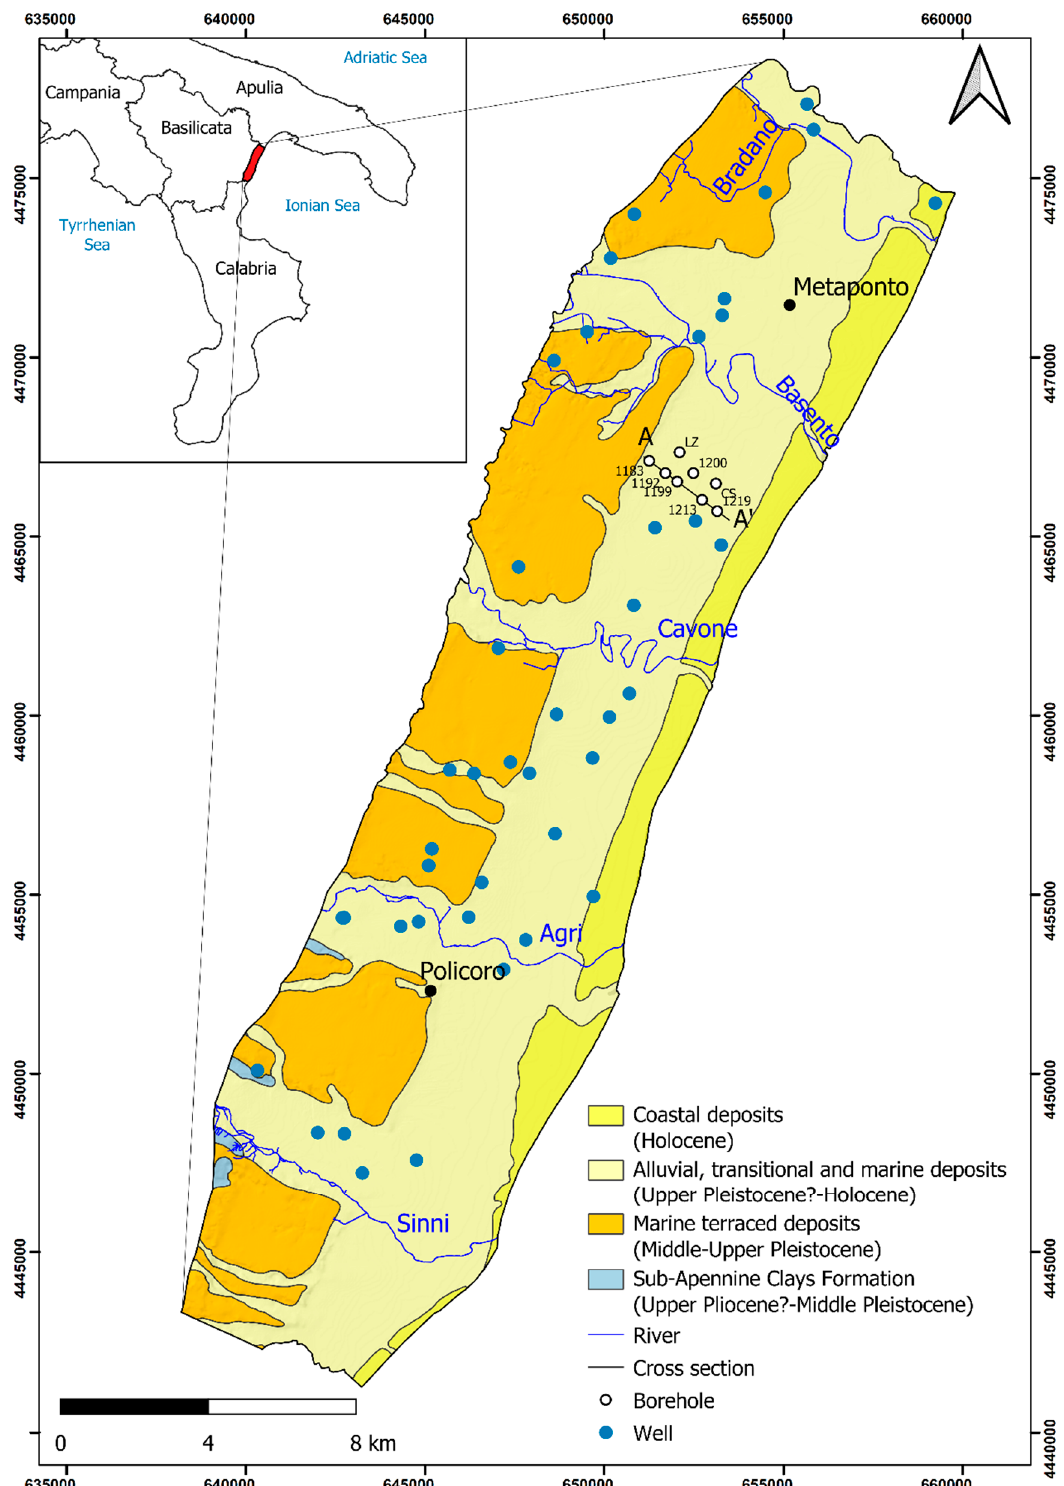
Figure 1. Schematic geological map of the Metaponto coastal plain (adapted from Geological Map of Italy 1:100,000 scale [54] and 1:50,000 scale [55]).